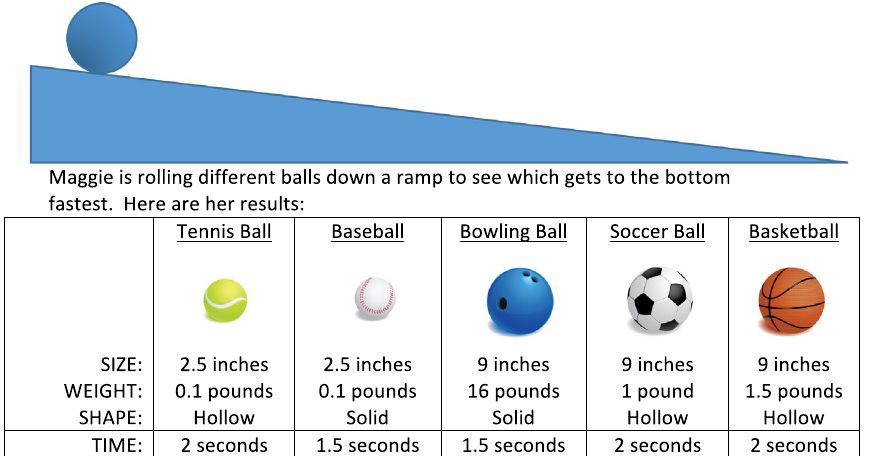
FIG. 1. The “ ramp ” post-test item. In two questions, students were asked to say which balls they would compare and to see if they could figure out what makes a difference in how fast a ball reaches the bottom of the